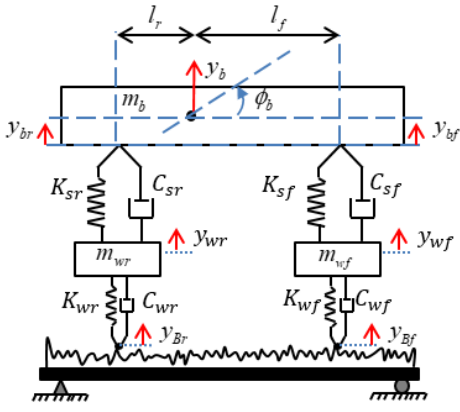
Figure 1. Vehicle-bridge interaction system.